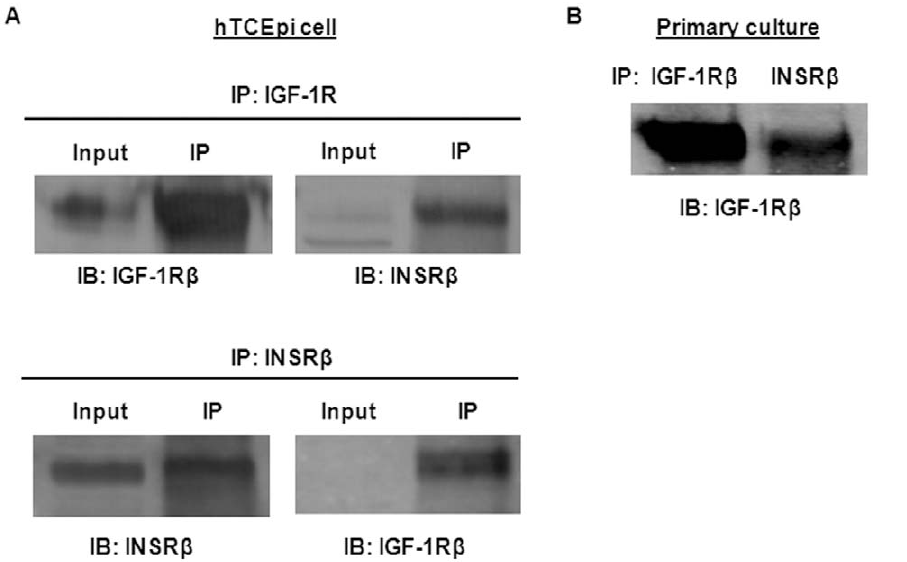
Figure 2. Presence of IGF-1 receptor and insulin receptor (IGF-1R/INSR) hybrid in corneal epithelium. (A) Reciprocal immunoprecipitation (IP) of IGF-1 receptor and insulin receptor in the hTCEpi cell line. Whole cell lysates were subjected to IP with antibodies against either the IGF-1 receptor (IGF-1R) b -subunit (CST # 3027) or the insulin receptor (INSR) b -subunit (C-19). Immunoprecipitated products were then immunoblotted with the same antibodies. Input represents the whole cell lysates before IP. (B) Co-precipitation of IGF-1R/INSR hybrid in primary corneal epithelial cell cultures. Protein lysates from passage 3 of human corneal epithelial cells were equally immunoprecipitated with anti-IGF-1R b (CST # 3027) or anti-INSR b (C-19), and detection of IGF-1R/IGF-1R or IGF-1R/INSR was performed with immunoblots with the same antibody against IGF-1R b .